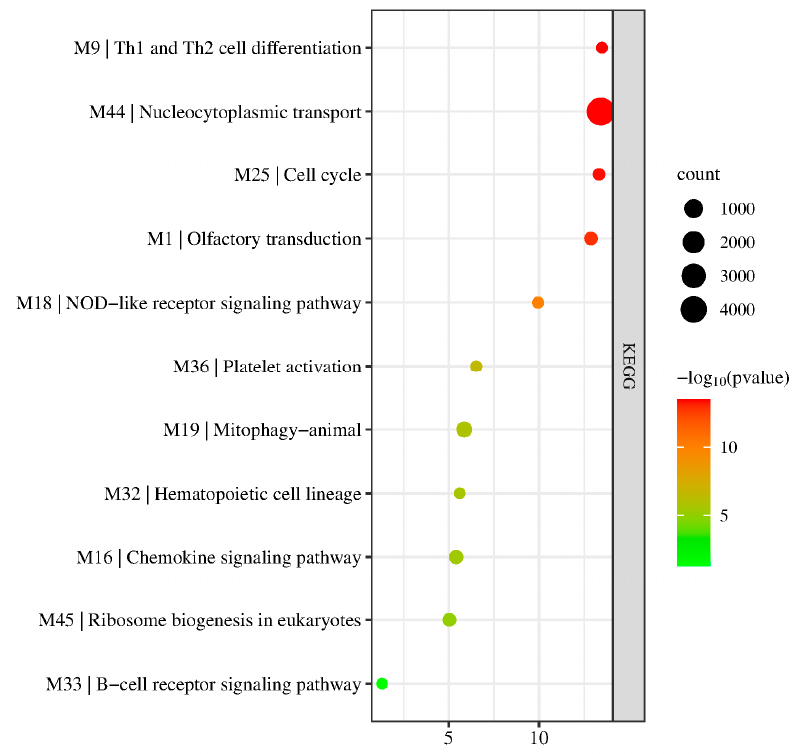
Figure 6. Bubble plots for the enriched KEGG pathways for each preserved module.